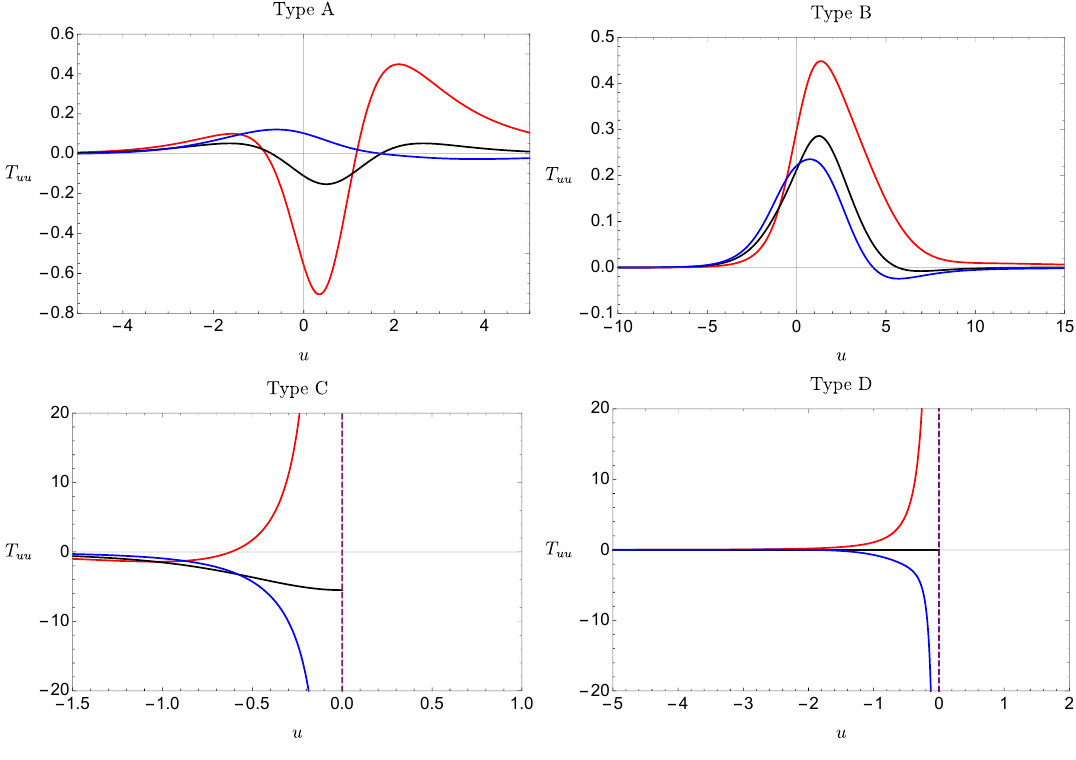
( u ) , A . Here, we have end